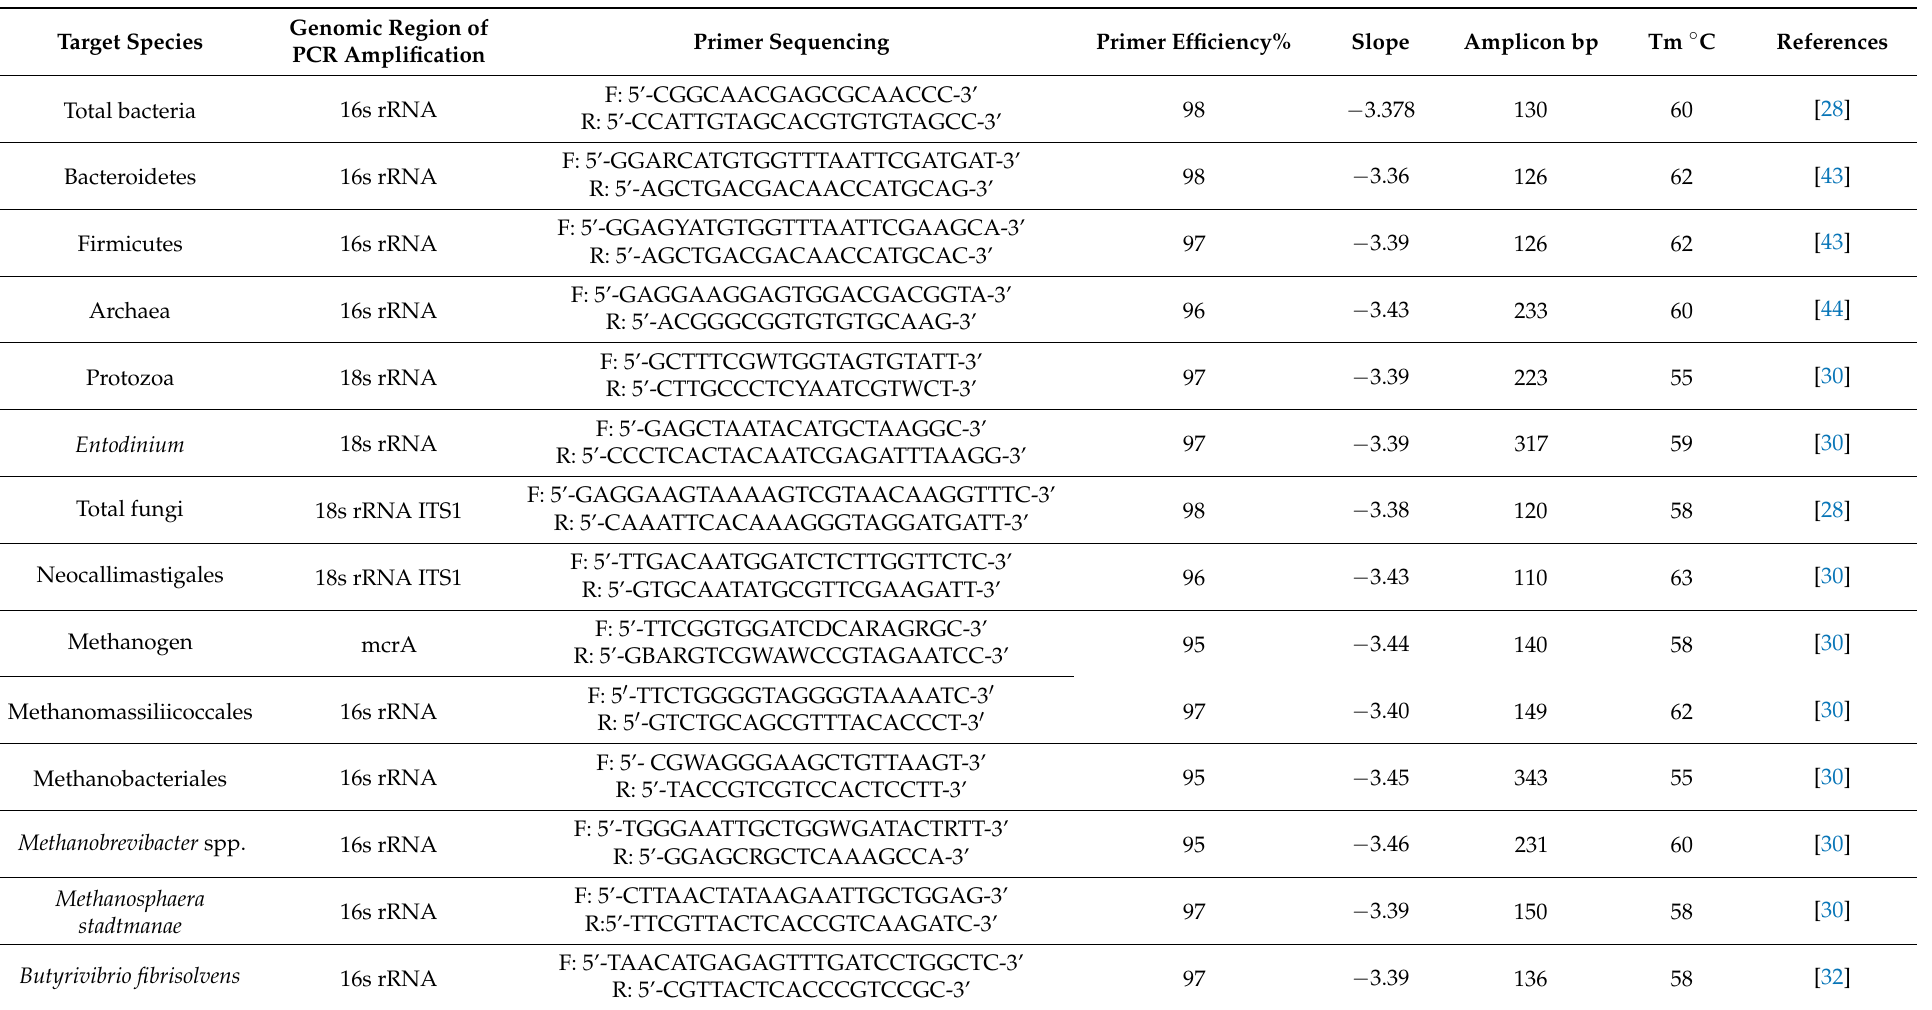
Table 3. Sequences of primers used for qPCRs, genomic regions of PCR amplification, primer efficiency, standard curve slope, amplicon size and hybridization